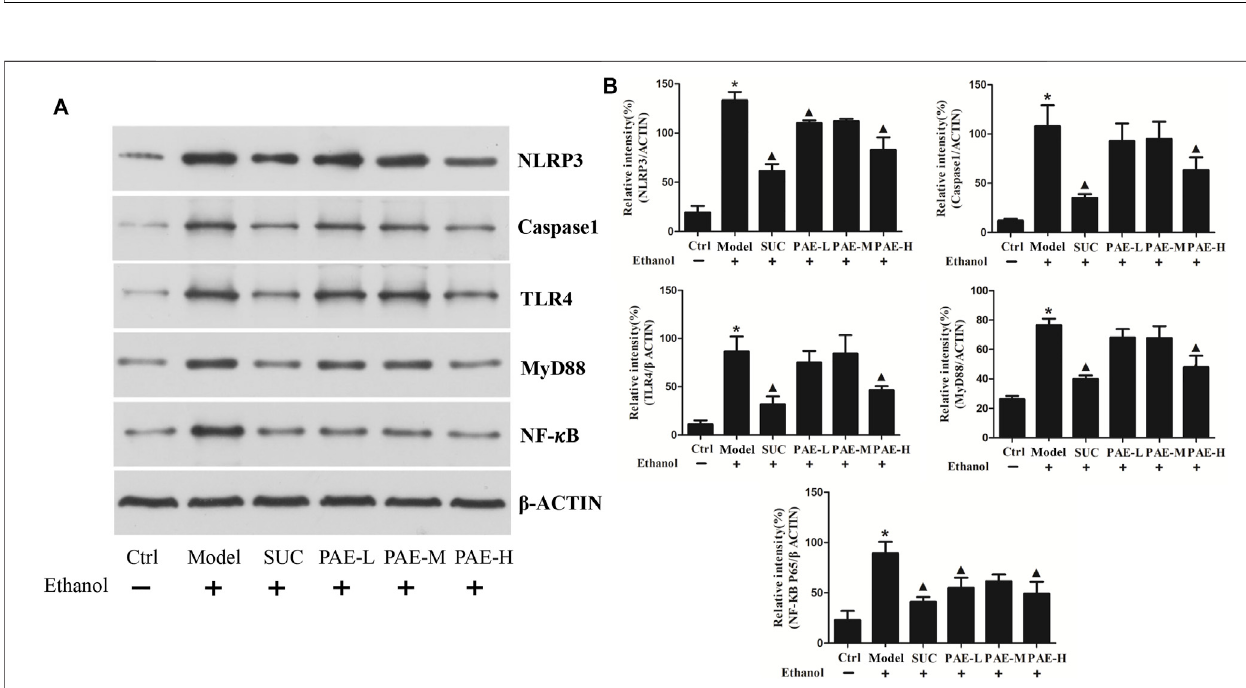
FIGURE7| In fl uenceofPAEontheexpressionsofprogrammedcelldeath-relatedproteinsinethanol-stimulatedgastrictissuesbywesternblotting.* p < 0.05,Ctrl group vs. Gastric ulcer model group; ▲ p < 0.05, PAE/SUC treatment group vs. Gastric ulcer model group.